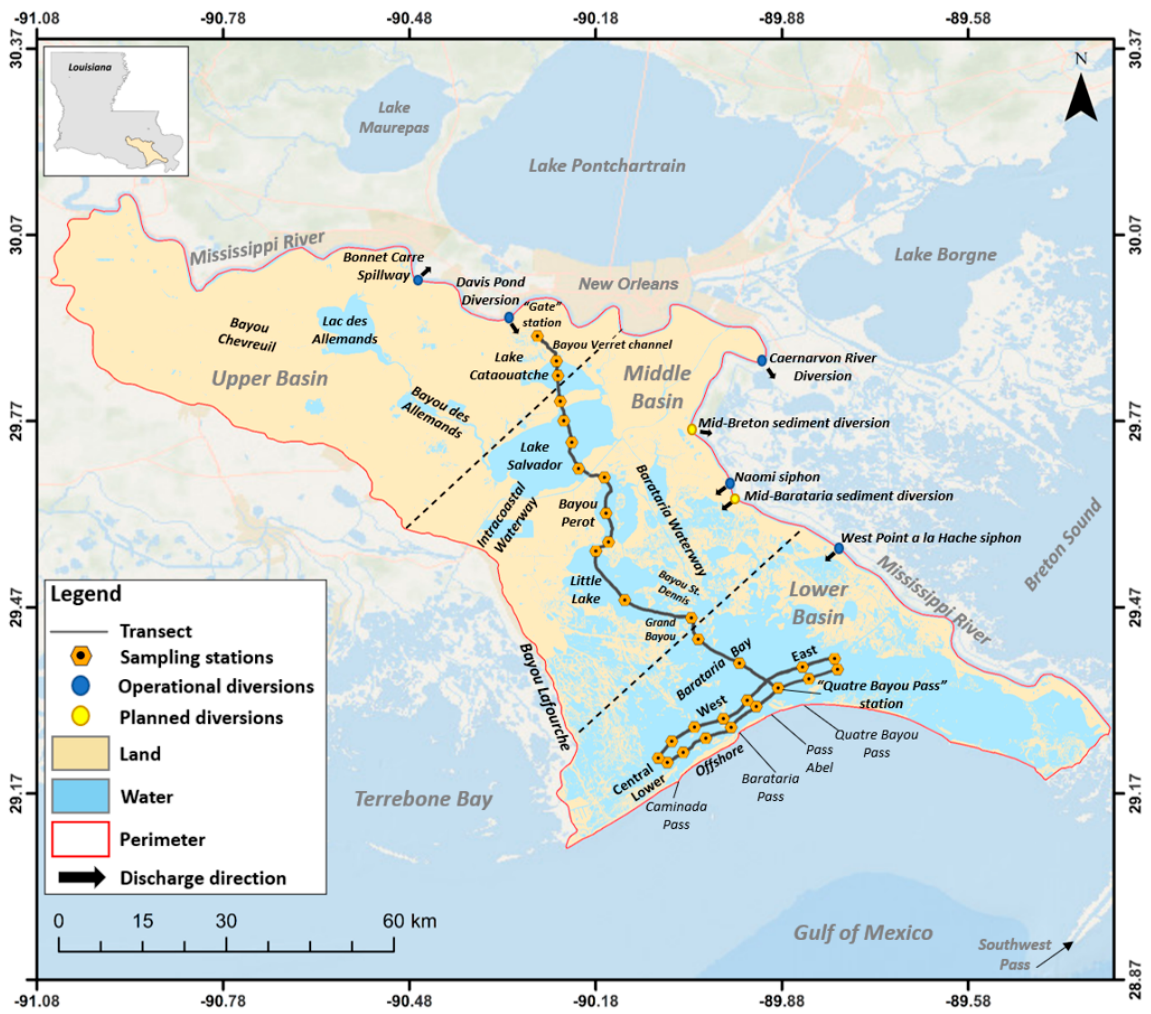
Figure 1. The Barataria Basin complex (BB) showing major hydrological features along the upper, middle, and lower basins and the array of sampling dataflow transects/discrete sampling stations. Water quality sampling started at the Bayou Verret channel (“Gate station”) upstream of Lake Cataouatche and continued seaward to the “Quatre Bayou Pass station” located ~4.0 km from the Quatre Bayou Pass.